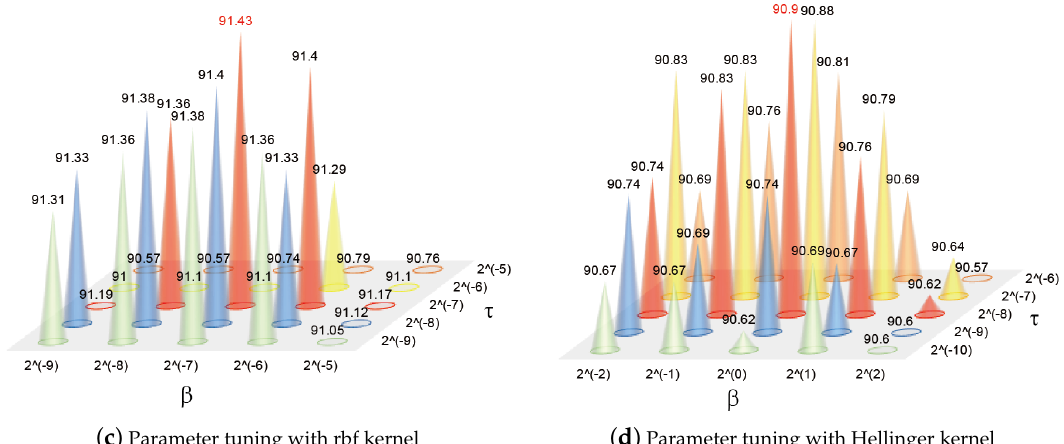
Figure 3. Parameter tuning on UC Merced Land Use Dataset.